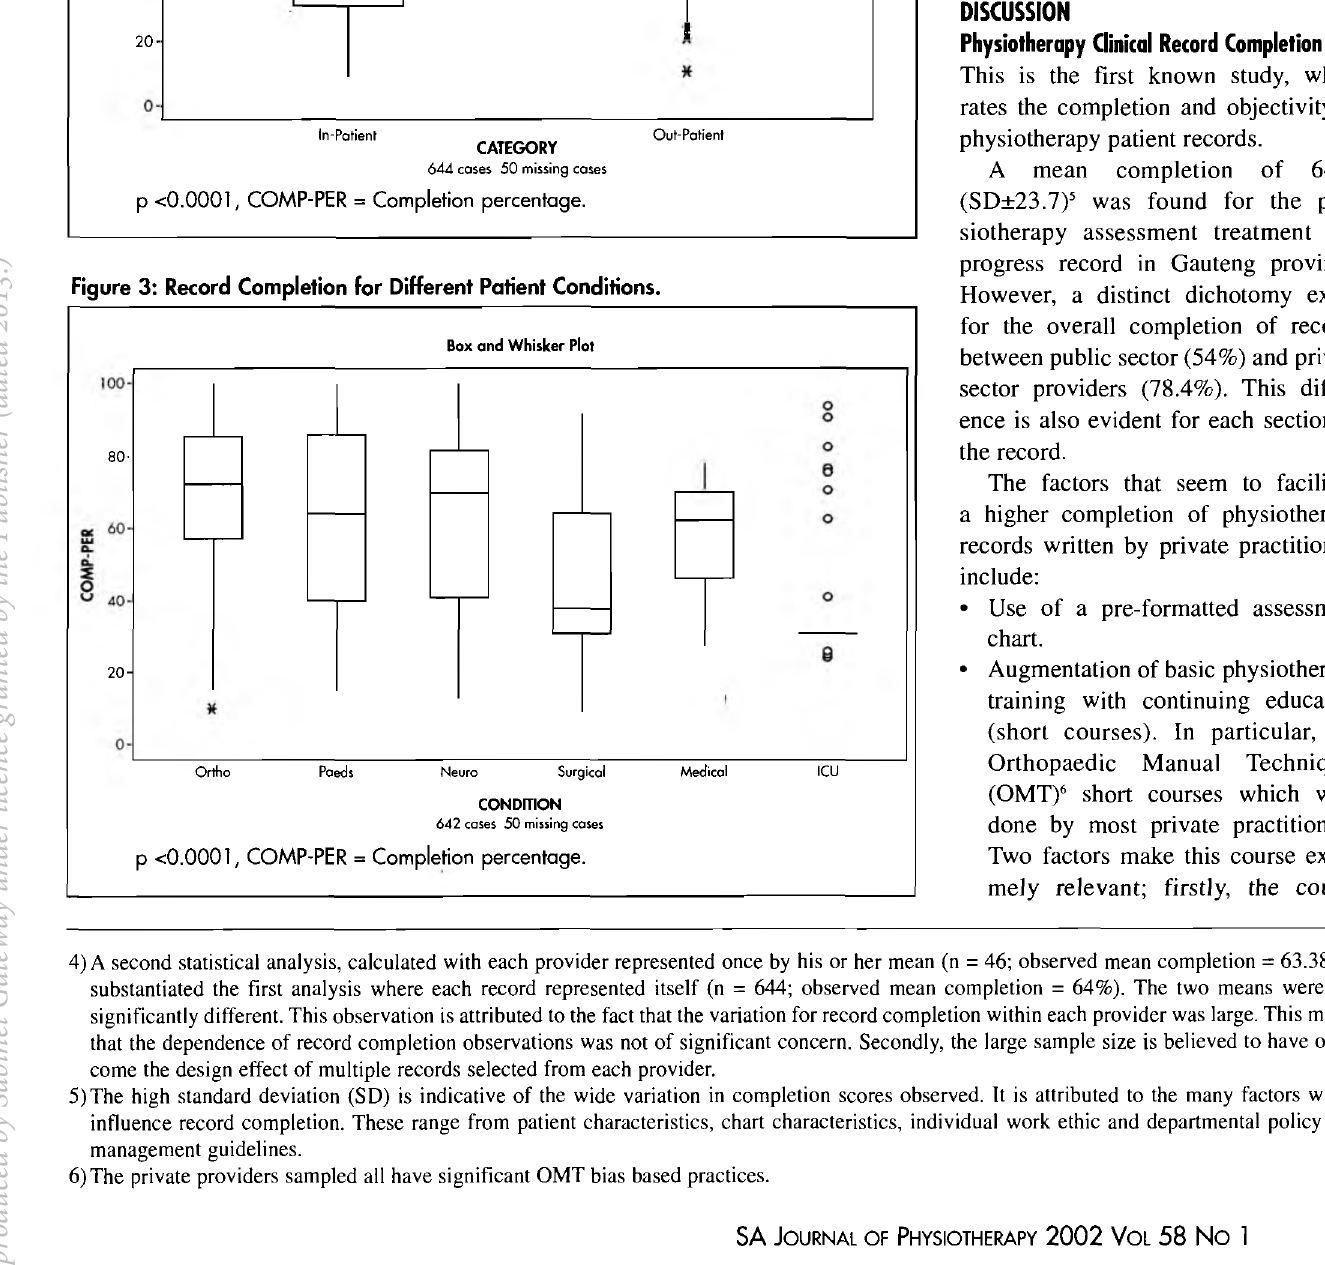
Figure 2: Record Completion for Patient Categories.